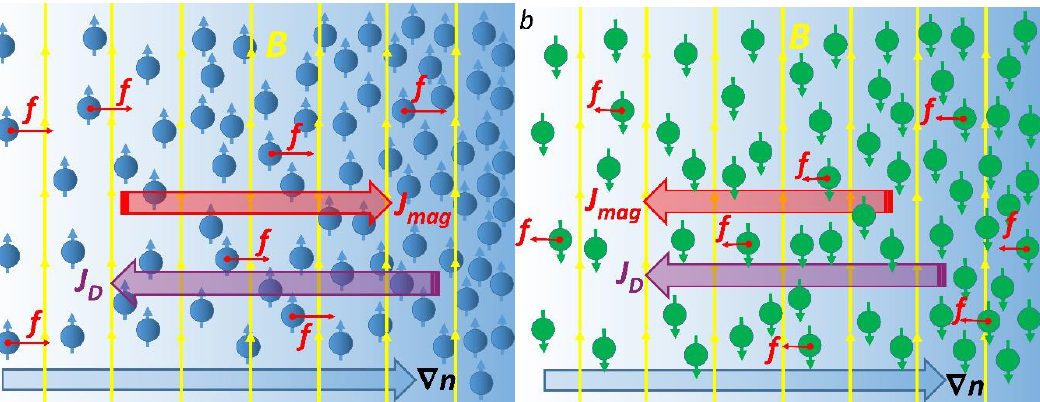
Figure 1. Sketch of the magnetically affected diffusion of paramagnetic ( a ) and diamagnetic molecules ( b ). The yellow arrows represent the magnetic field lines. The large blue arrow shows the concentration gradient ∇ n of solute. Red arrows show the magnetic concentration-gradient forces (Equation (1)) acting on the molecules.